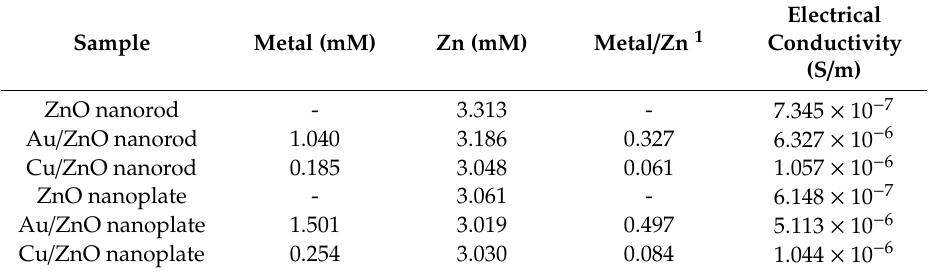
Figure 2. TEM images and selected area electron diffraction patterns of metal-deposited ZnO nanostructures: ( a ) ZnO nanorod, ( b ) ZnO nanoplate, ( c ) Au / ZnO nanorod ( d ) Au / ZnO nanoplate, ( e ) Cu / ZnO nanorod, and ( f ) Cu / ZnO nanoplate. Table 2. The elemental ratio in different metal-deposited ZnO nanostructures and the electrical conductivity of the metal-deposited ZnO nanostructures.